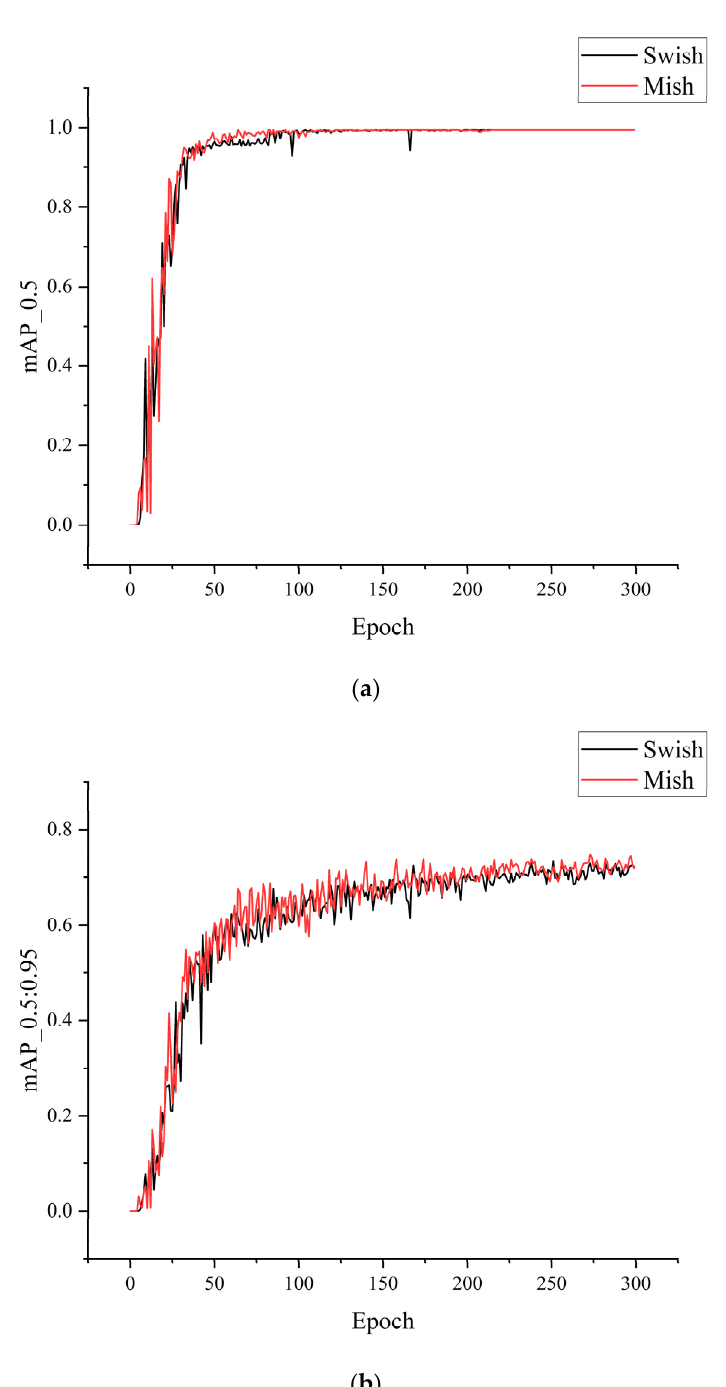
Figure 6. Comparison of the Mish and Swish activation function on the SSDD dataset for ( a ) mAP _0.5; ( b ) mAP _0.5 :